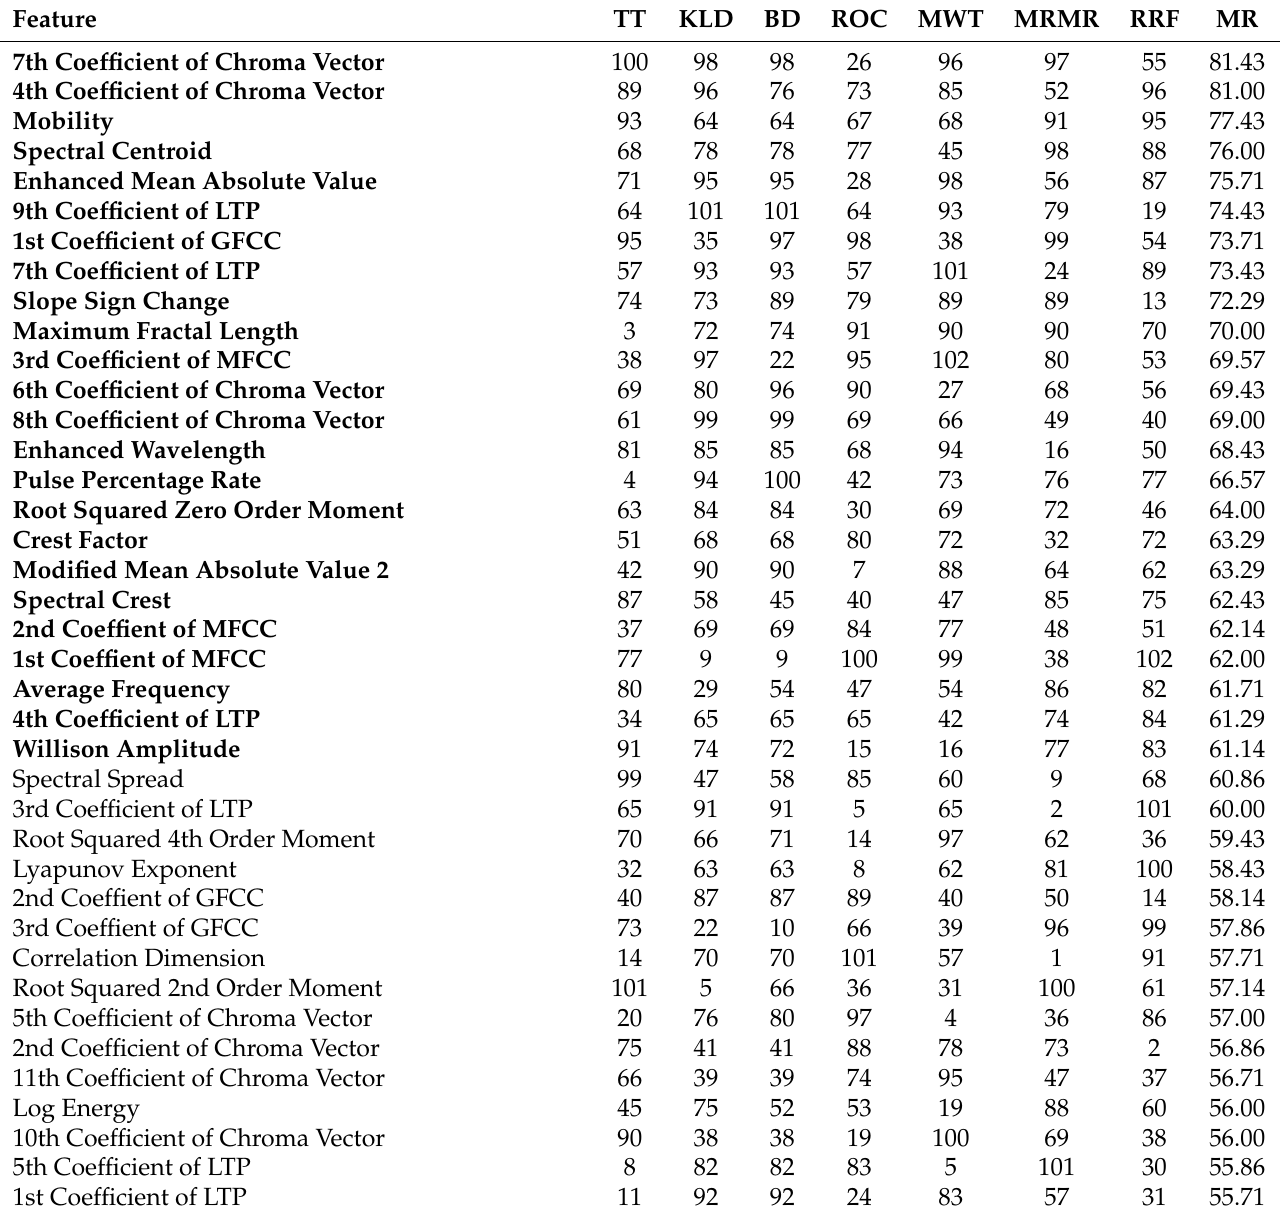
Table 8. List of features extracted for method II and sorted with respect to MR value. Bold font indicates the top 24 ranked